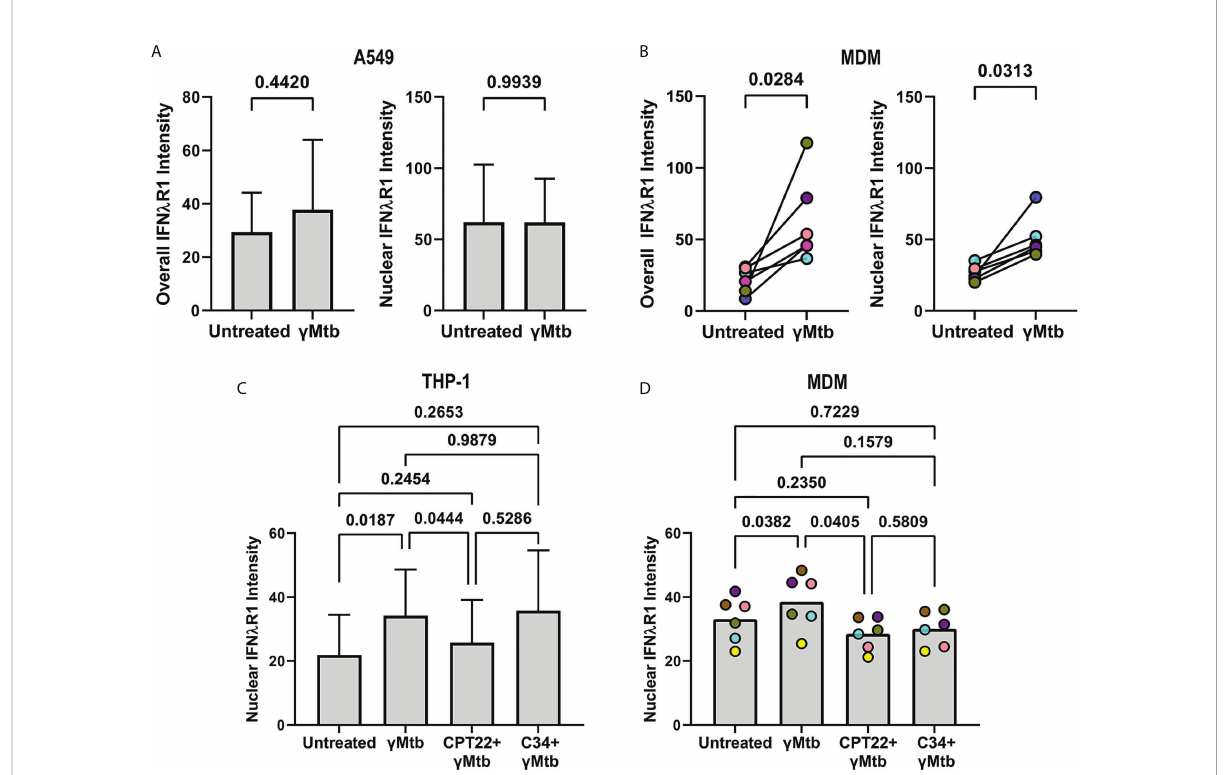
FIGURE 9 TLR2 mediated signaling by gamma-irradiated Mtb regulates IFN l R1 expression and localization in myeloid cells. (A) Comparison of overall (left) and nuclear (right) IFNlR1 intensity in gamma-irradiated Mtb-stimulated A549 epithelial cells. Bars and lines represent the mean value and standard deviation from 5 independent experiments with statistical comparisons by paired t test. (B) Overall (left) and nuclear (right) IFN l R1 intensity in gamma-irradiated Mtb-stimulated macaque monocyte derived macrophages (MDMs; n=6). Each point depicts the median IFN l R1 value in macrophages, with each marker ’ s color representing a different animal. Statistical comparisons by Wilcoxon matched-pairs signed rank test and paired t test, respectively. (C) Comparison of nuclear IFN l R1 intensity in gamma-irradiated Mtb stimulated THP-1 cells with or without CU CPT22 (TLR2 antagonist) and C34 (TLR4 antagonist). Bars and lines represent mean values and standard deviation of 7 independent experiments. RM one-way ANOVA used to account for repeated measures and pairwise groups compared using Tukey ’ s multiple comparisons test (Tukey ’ s adjusted p-values reported). (D) Comparison of nuclear IFN l R1 intensity in gamma-irradiated Mtb-stimulated macaque MDMs with or without CU CPT22 (TLR2 antagonist) and C34 (TLR4 antagonist) (n=6). Each point depicts the median IFN l R1 value for an animal ’ s MDMs, with each marker ’ s color representing a different animal. RM one-way ANOVA used to account for repeated measures and pairwise groups compared using Tukey ’ s multiple comparisons test (Tukey ’ s adjusted p-values